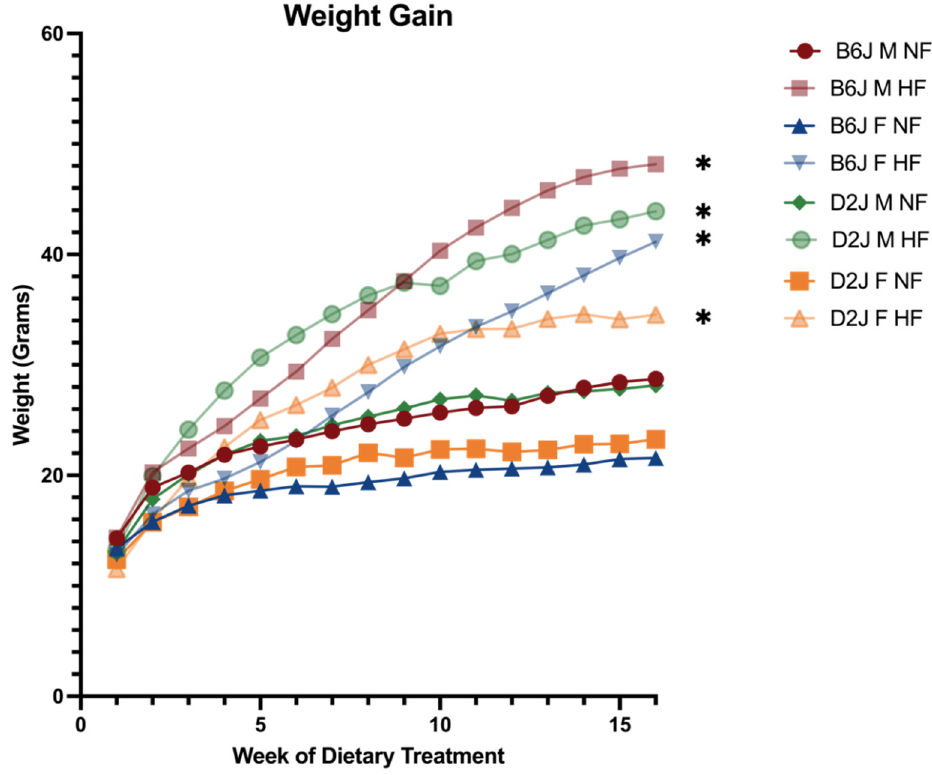
Figure 1. Average body weight over 16-week diet intervention. Comparisons between normal fat and high fat diet groups were conducted for B6J and D2J males and females at the beginning (week 1) and end of diet intervention (week 16). There were no significant differences in initial body weight between normal fat and high fat groups. Following a 16-week diet intervention, there were significant differences in weight between normal fat and high fat groups for males and females of both B6J and D2J strains. * p < 0.05. B6J M LF = B6J male normal fat, B6J M HF = B6J male high fat, B6J F LF = B6J female normal fat, B6J F HF = B6J female high fat, D2J M LF = D2J male normal fat, D2J M HF = D2J male high fat, D2J F LF = D2J female normal fat, D2J F HF = D2J female high fat.